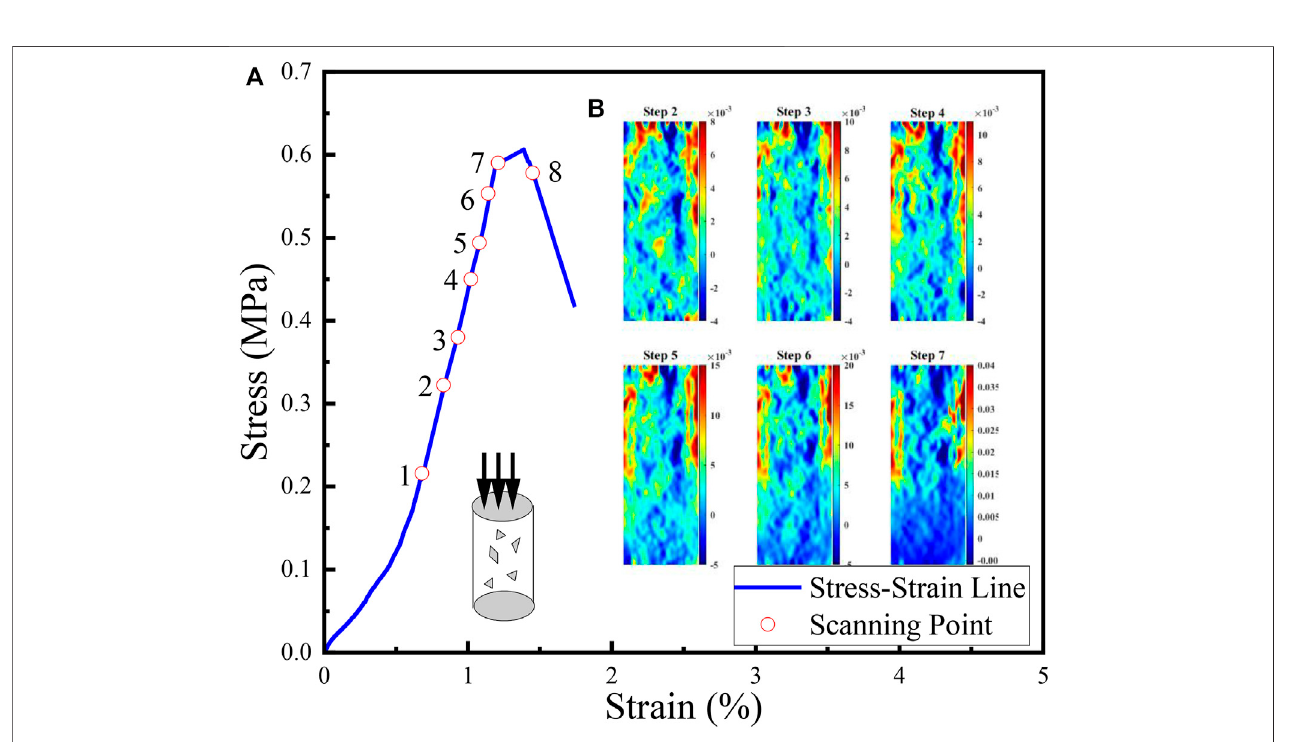
FIGURE 4 | (A) Stress – strain curves for the SRM; (B) Radial deformation of the SRM under seven stress strengths (steps 2 – 7, respectively).